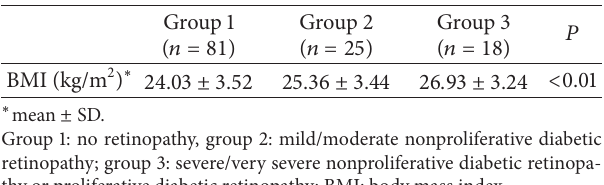
Table4:Bodymassindex(BMI)oftype1diabeticpatients( 𝑛 = 124 ) withoutnephropathydividedintothreegroupsaccordingtodiabetic retinopathy